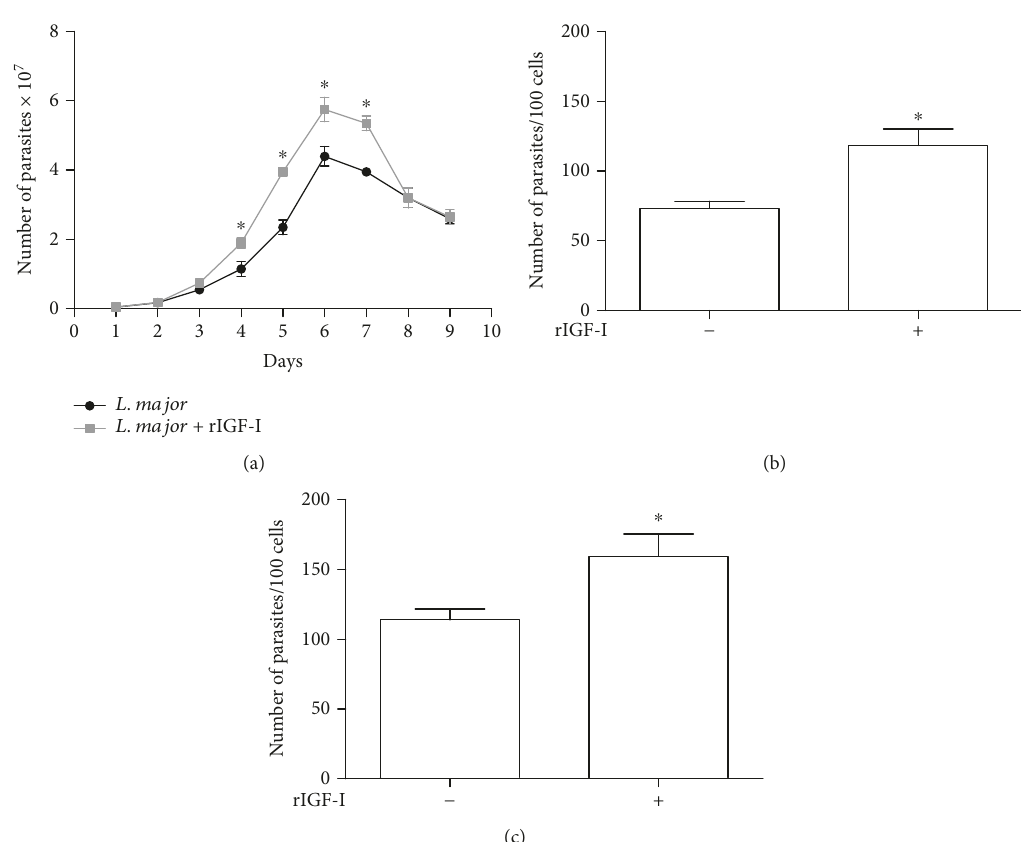
Figure 1: The e ff ects of IGF-I on the growth of L. major in culture and within macrophages ( mean ± standard deviation). (a) The e ff ect of IGF-I on the growth of Leishmania promastigotes in culture maintained in 199 medium supplemented with 2% heat-inactivated FCS at 26 ° C is shown. Leishmania promastigotes were maintained with (gray line) or without (black line) 50 ng/mL rIGF-I. (b and c) The e ff ect of IGF-I on the growth of Leishmania within macrophages is shown. RAW 264.7 cells were infected with L. major promastigotes (b) or amastigotes (c) treated with or without 50ng/mL rIGF-I and incubated for 48 h. ∗ P < 0 05 (one-way ANOVA and Student ’ s t test) compared to the control without